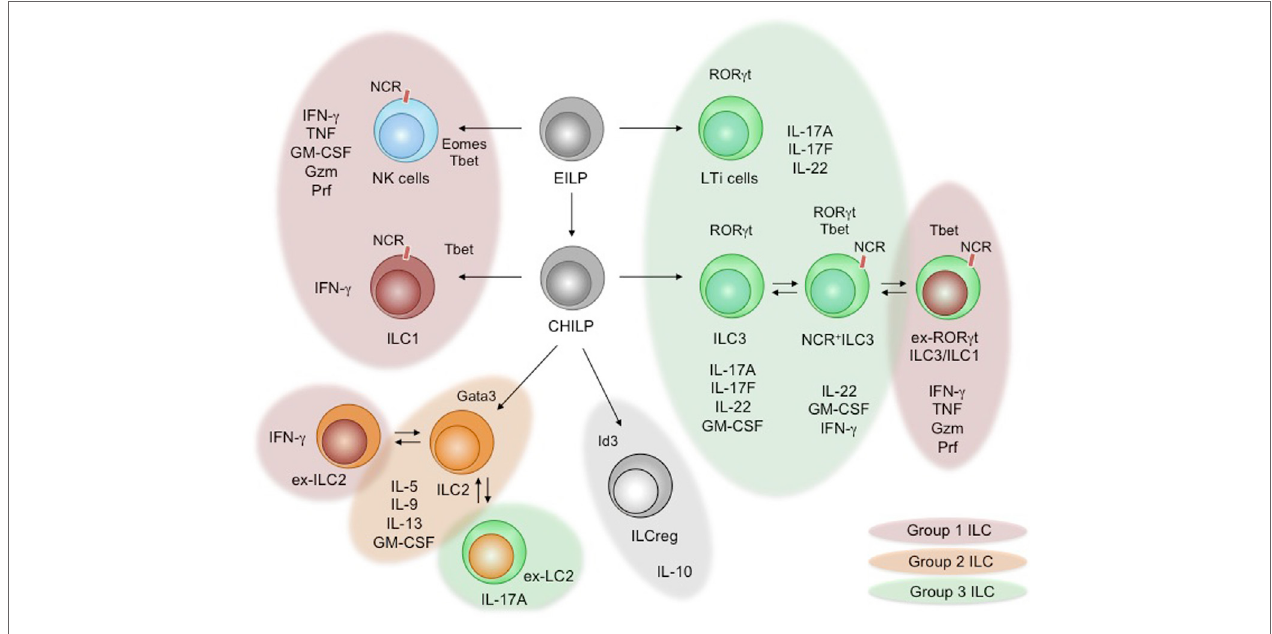
FiGURe 1 | Development and functional specialization of innate lymphoid cells (ILCs). The diagram shows the developmental pathways of ILCs and branching into their different lineages. The early innate lymphoid precursor (EILP) and the common helper innate lymphoid precursor (CHILP) are progenitors to all ILCs (36, 37). Critical lineage-determining transcription factors are shown. Arising ILCs [natural killer (NK) cells, lymphoid tissue inducer (LT) cells, ILC1–3, and ILCreg] are displayed, including arising subsets. Individual groups of ILCs are indicated through color schemes. The expression of natural cytotoxicity receptors (NCRs) on ILC subsets is indicated. Specific and shared effector cytokines secreted during inflammation and steady state are listed below the indicated subsets of ILCs. Documented plasticity within group 2 ILCs and group 3 ILCs is indicated using overlapping and colored